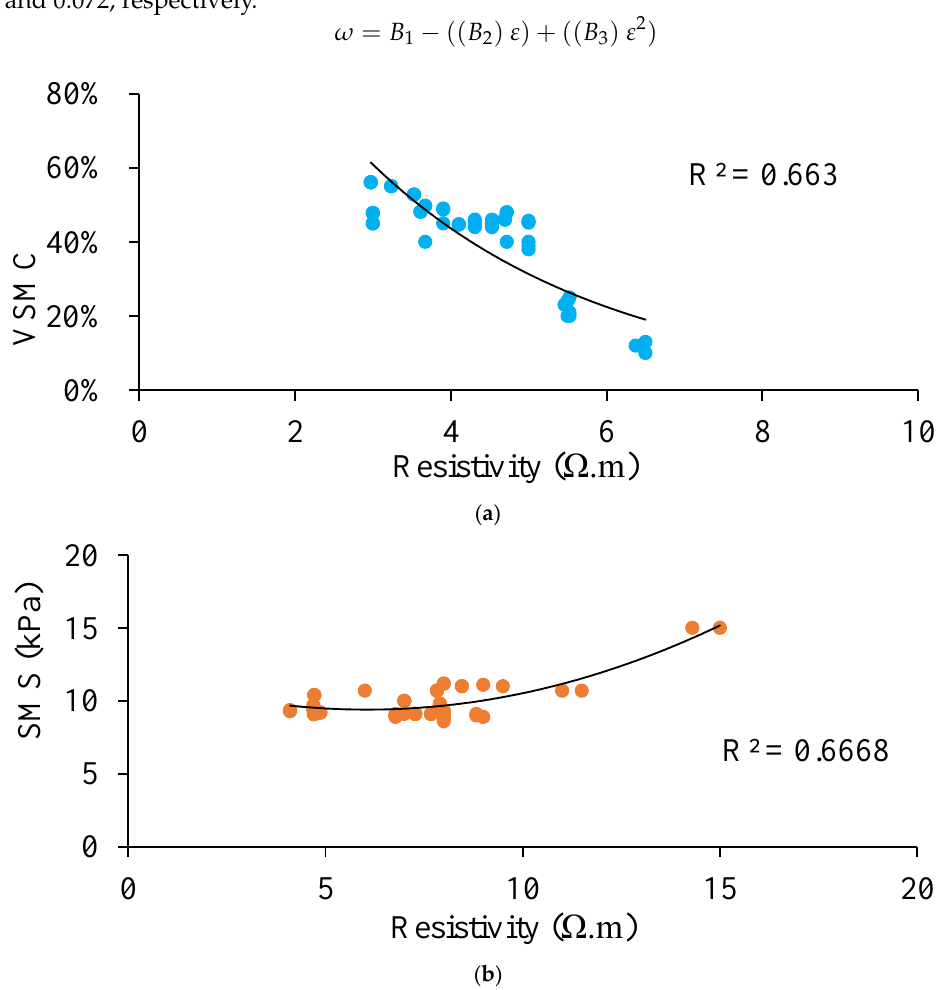
Figure 32. Variation of combined soil resistivity along with VSMC SMS of the six HWS ( a ) VSMC field-based model ( b ) SMS field-based model (1 kPa = 20.89 psf).